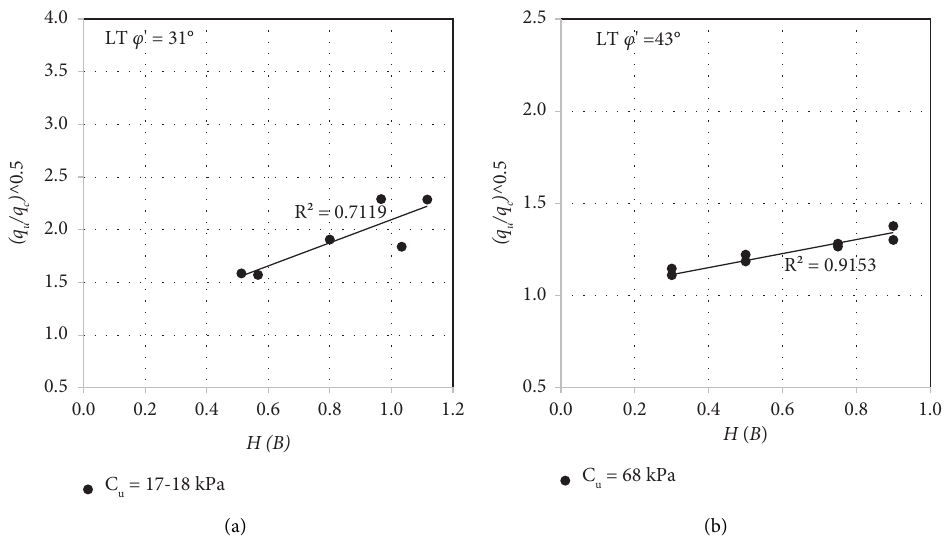
Figure 6: ( q q ) 0 . 5 versus H/B for an unstabilised granular layer (data source: (a) Lee et al. [33] and (b) Hemalatha et al. [35]): (a) LT ϕ ′ � 31 ° u / c and (b) LT ϕ ′ � 43 ° .